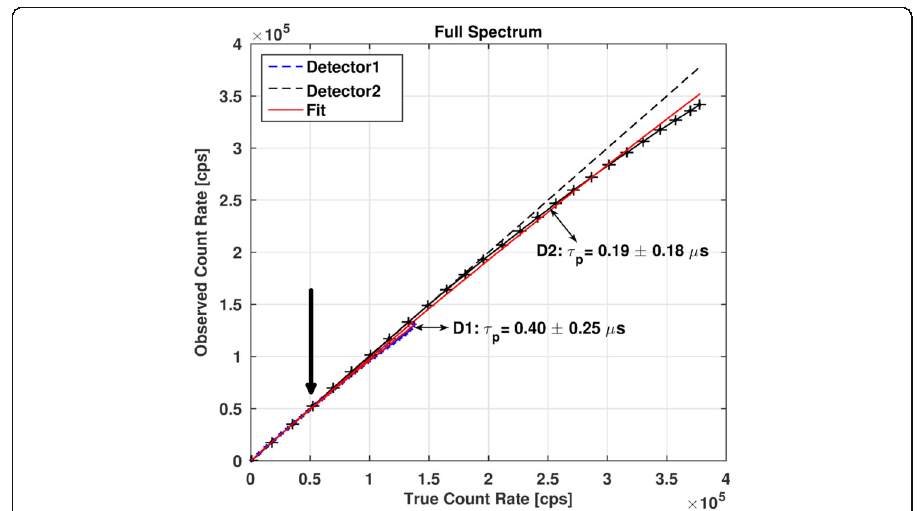
Fig. 4 Observed count rates vs. true count rates for the full spectrum. The values of τ p determined for both detectors are shown. Crosses indicate the measured data points. Typical values of full spectrum count rates in patient studies (indicated by an arrow) range from 50 to 70 kcps (~ 0.6 × 10 5 cps on this